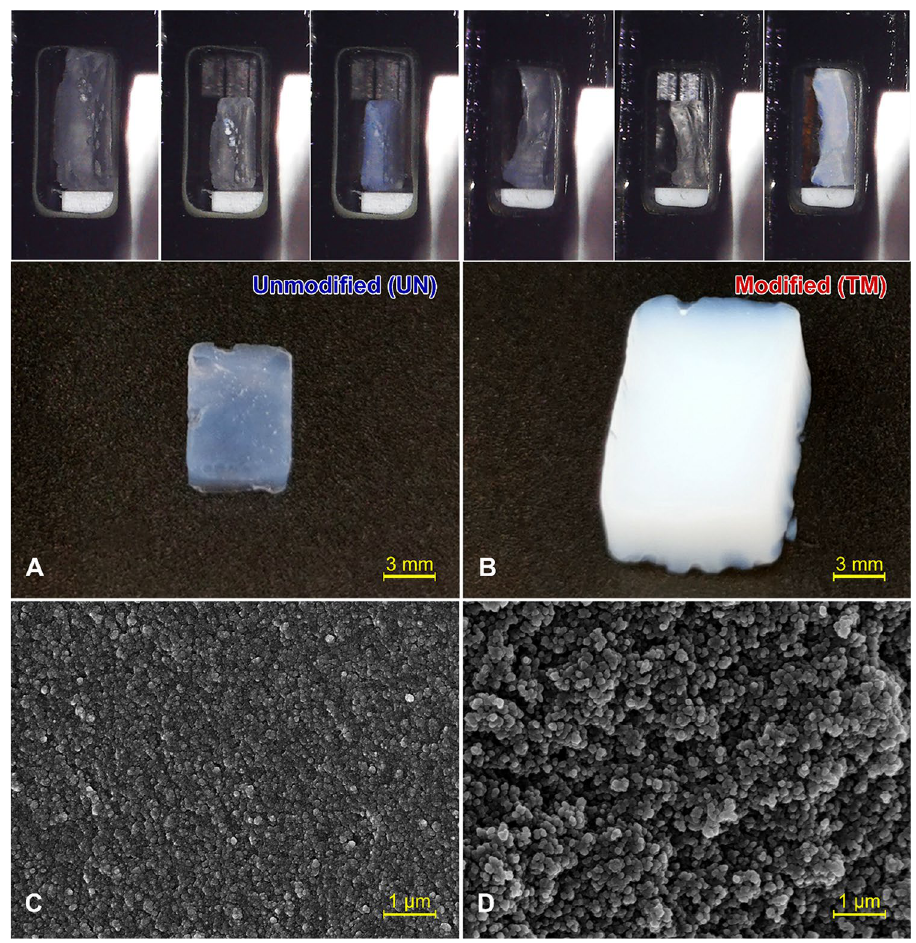
Figure 1. ( A , B ) Photographs of dried unmodified UN and modified TM samples, showing a different width, color, and transparency. Additionally, distinct changes while drying and the shrinkage of the samples are shown above. ( C , D ) SEM images of an unmodified UN and modified TM sample, displaying severely different surface porosity at the micrometer